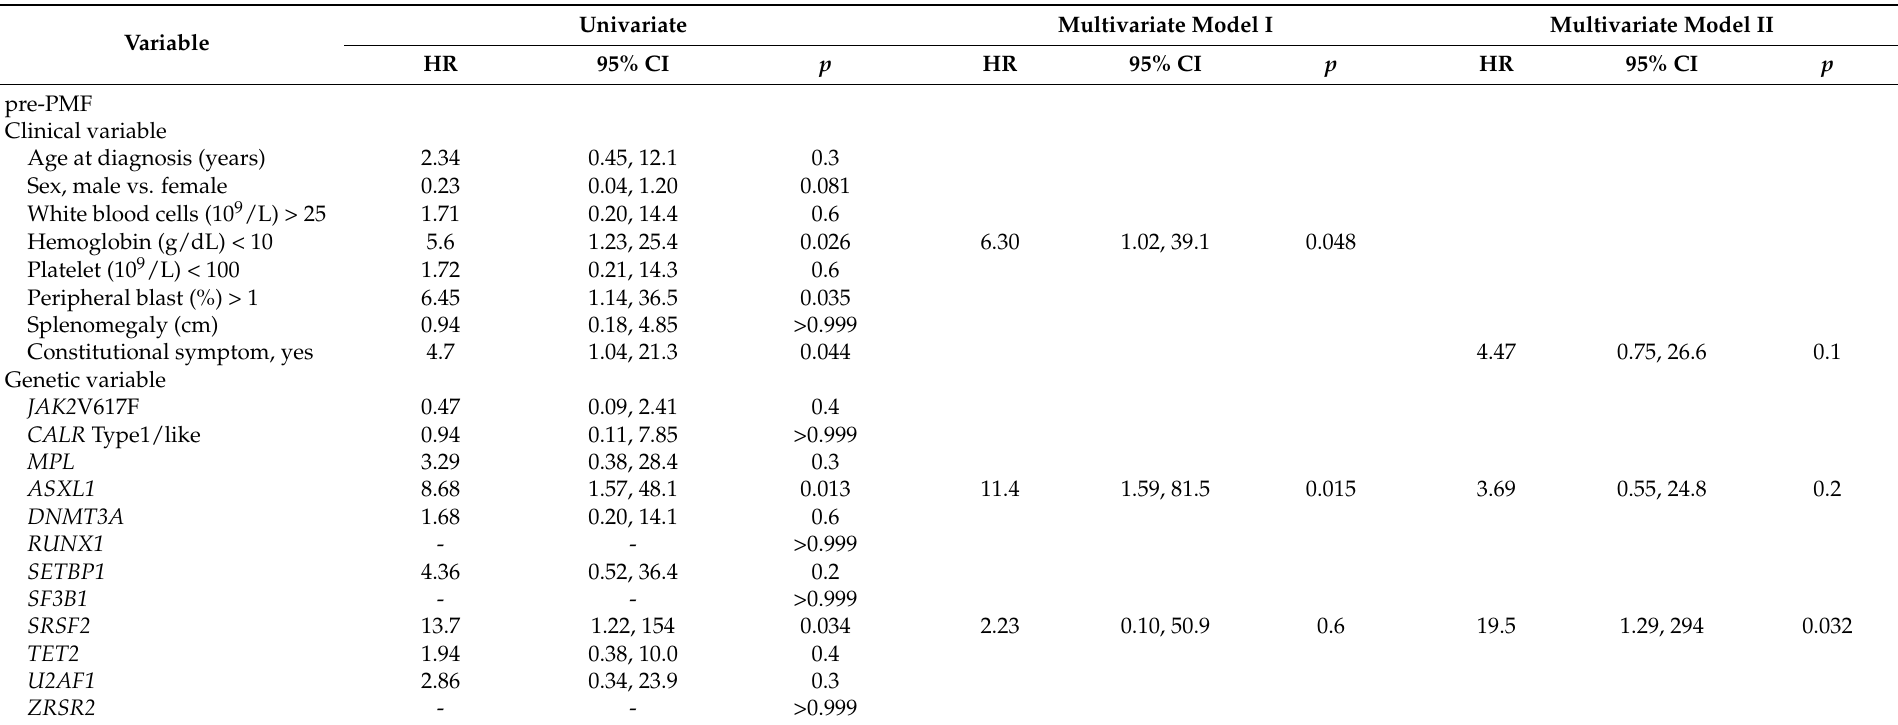
Table 4. Estimation of progression-free survival using univariate and multivariate analyses of clinical and genetic factors in patients with pre-PMF.